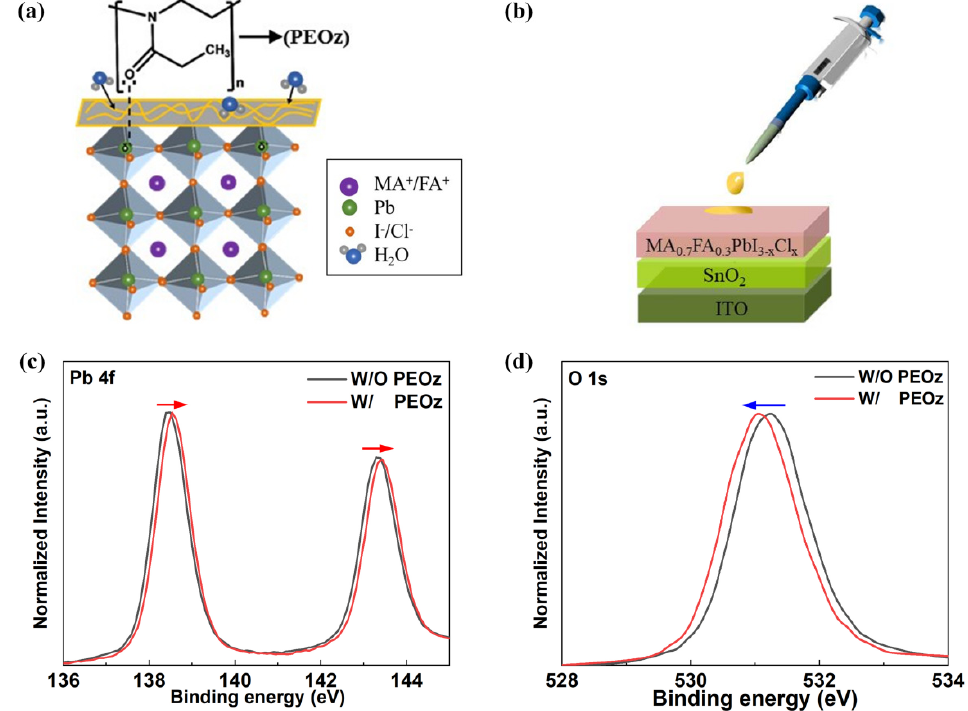
Figure 1. ( a ) Illustration of PEOz passivation mechanism. ( b ) Schematic diagram of PEOz spin coated on perovskite film. ( c ) Core − level Pb 4f and ( d ) O 1s XPS spectra of MA 0.7 FA 0.3 PbI 3 − x Cl x films with and without PEOz passivation.